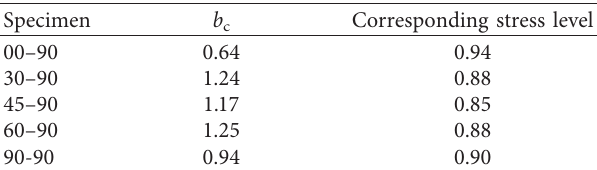
Figure 7: The relationship between the b -value of AE and the stress level for the specimens with orthogonal cracks. Table 2: The critical b -values of AE and the corresponding stress